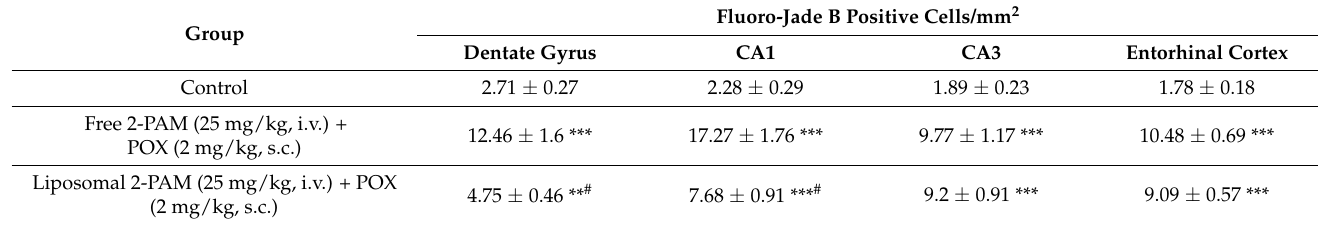
Table 5. Protection of mice against POX toxicity.